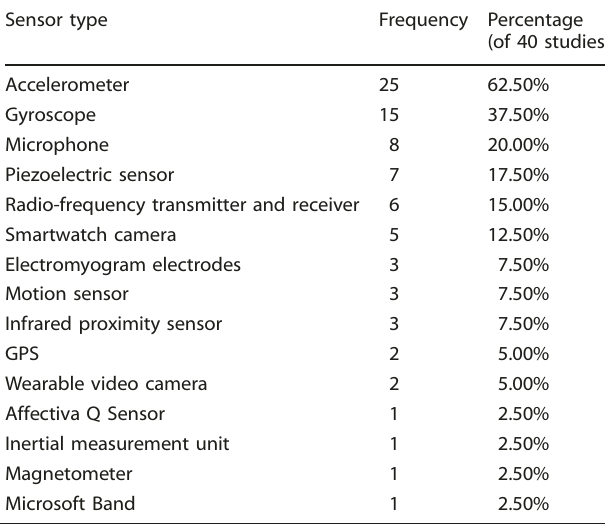
Table 2. Frequency and percentage of sensor types in included studies, ordered by